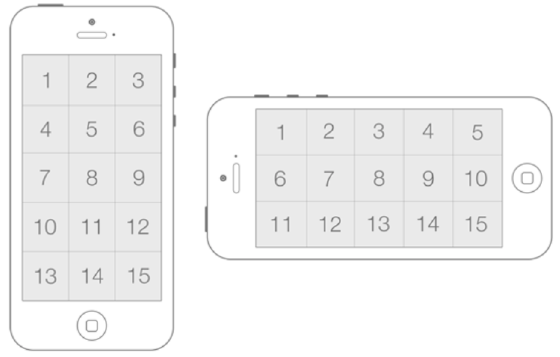
Figure 7. Regions of the screen in portrait and landscape right orientation.